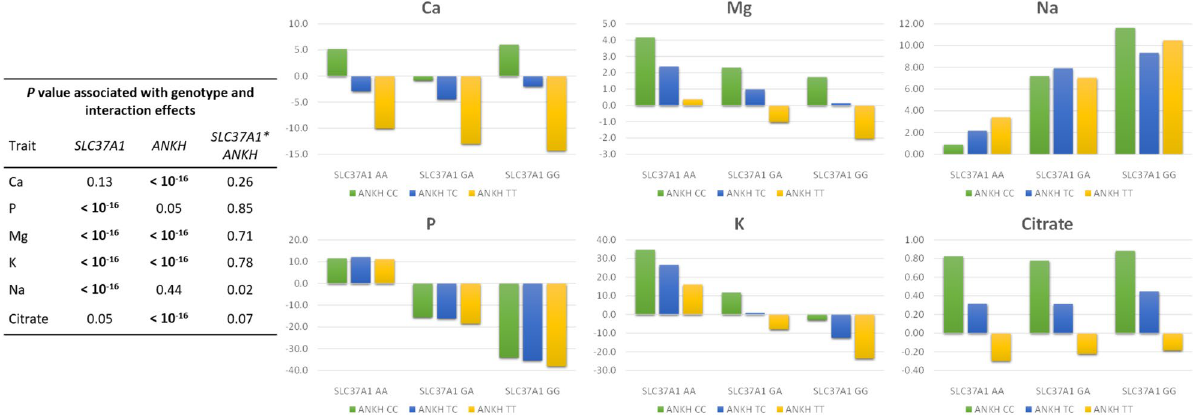
Figure 5. SLC37A1 and ANKH genotypes and genotype interaction effects on milk mineral (Ca, P, Mg, K, and Na) or citrate